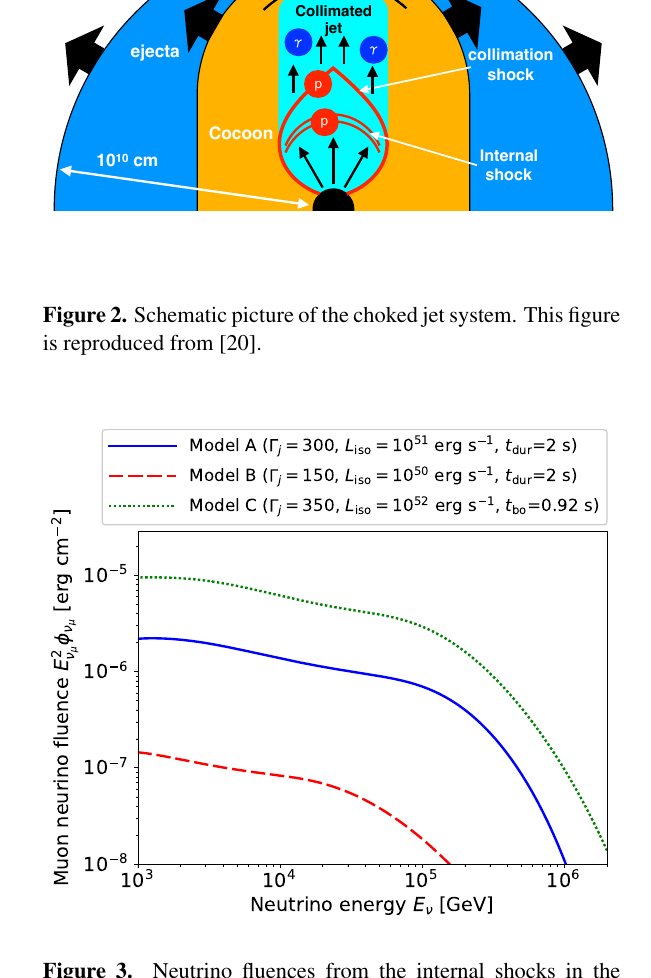
Figure 3. Neutrino fluences from the internal shocks in the choked jet system. The solid and dashed lines show the opti- mistic and moderate cases, respectively. The dotted line indi- cates the precursor neutrinos of the successful jet. This figure is reproduced from